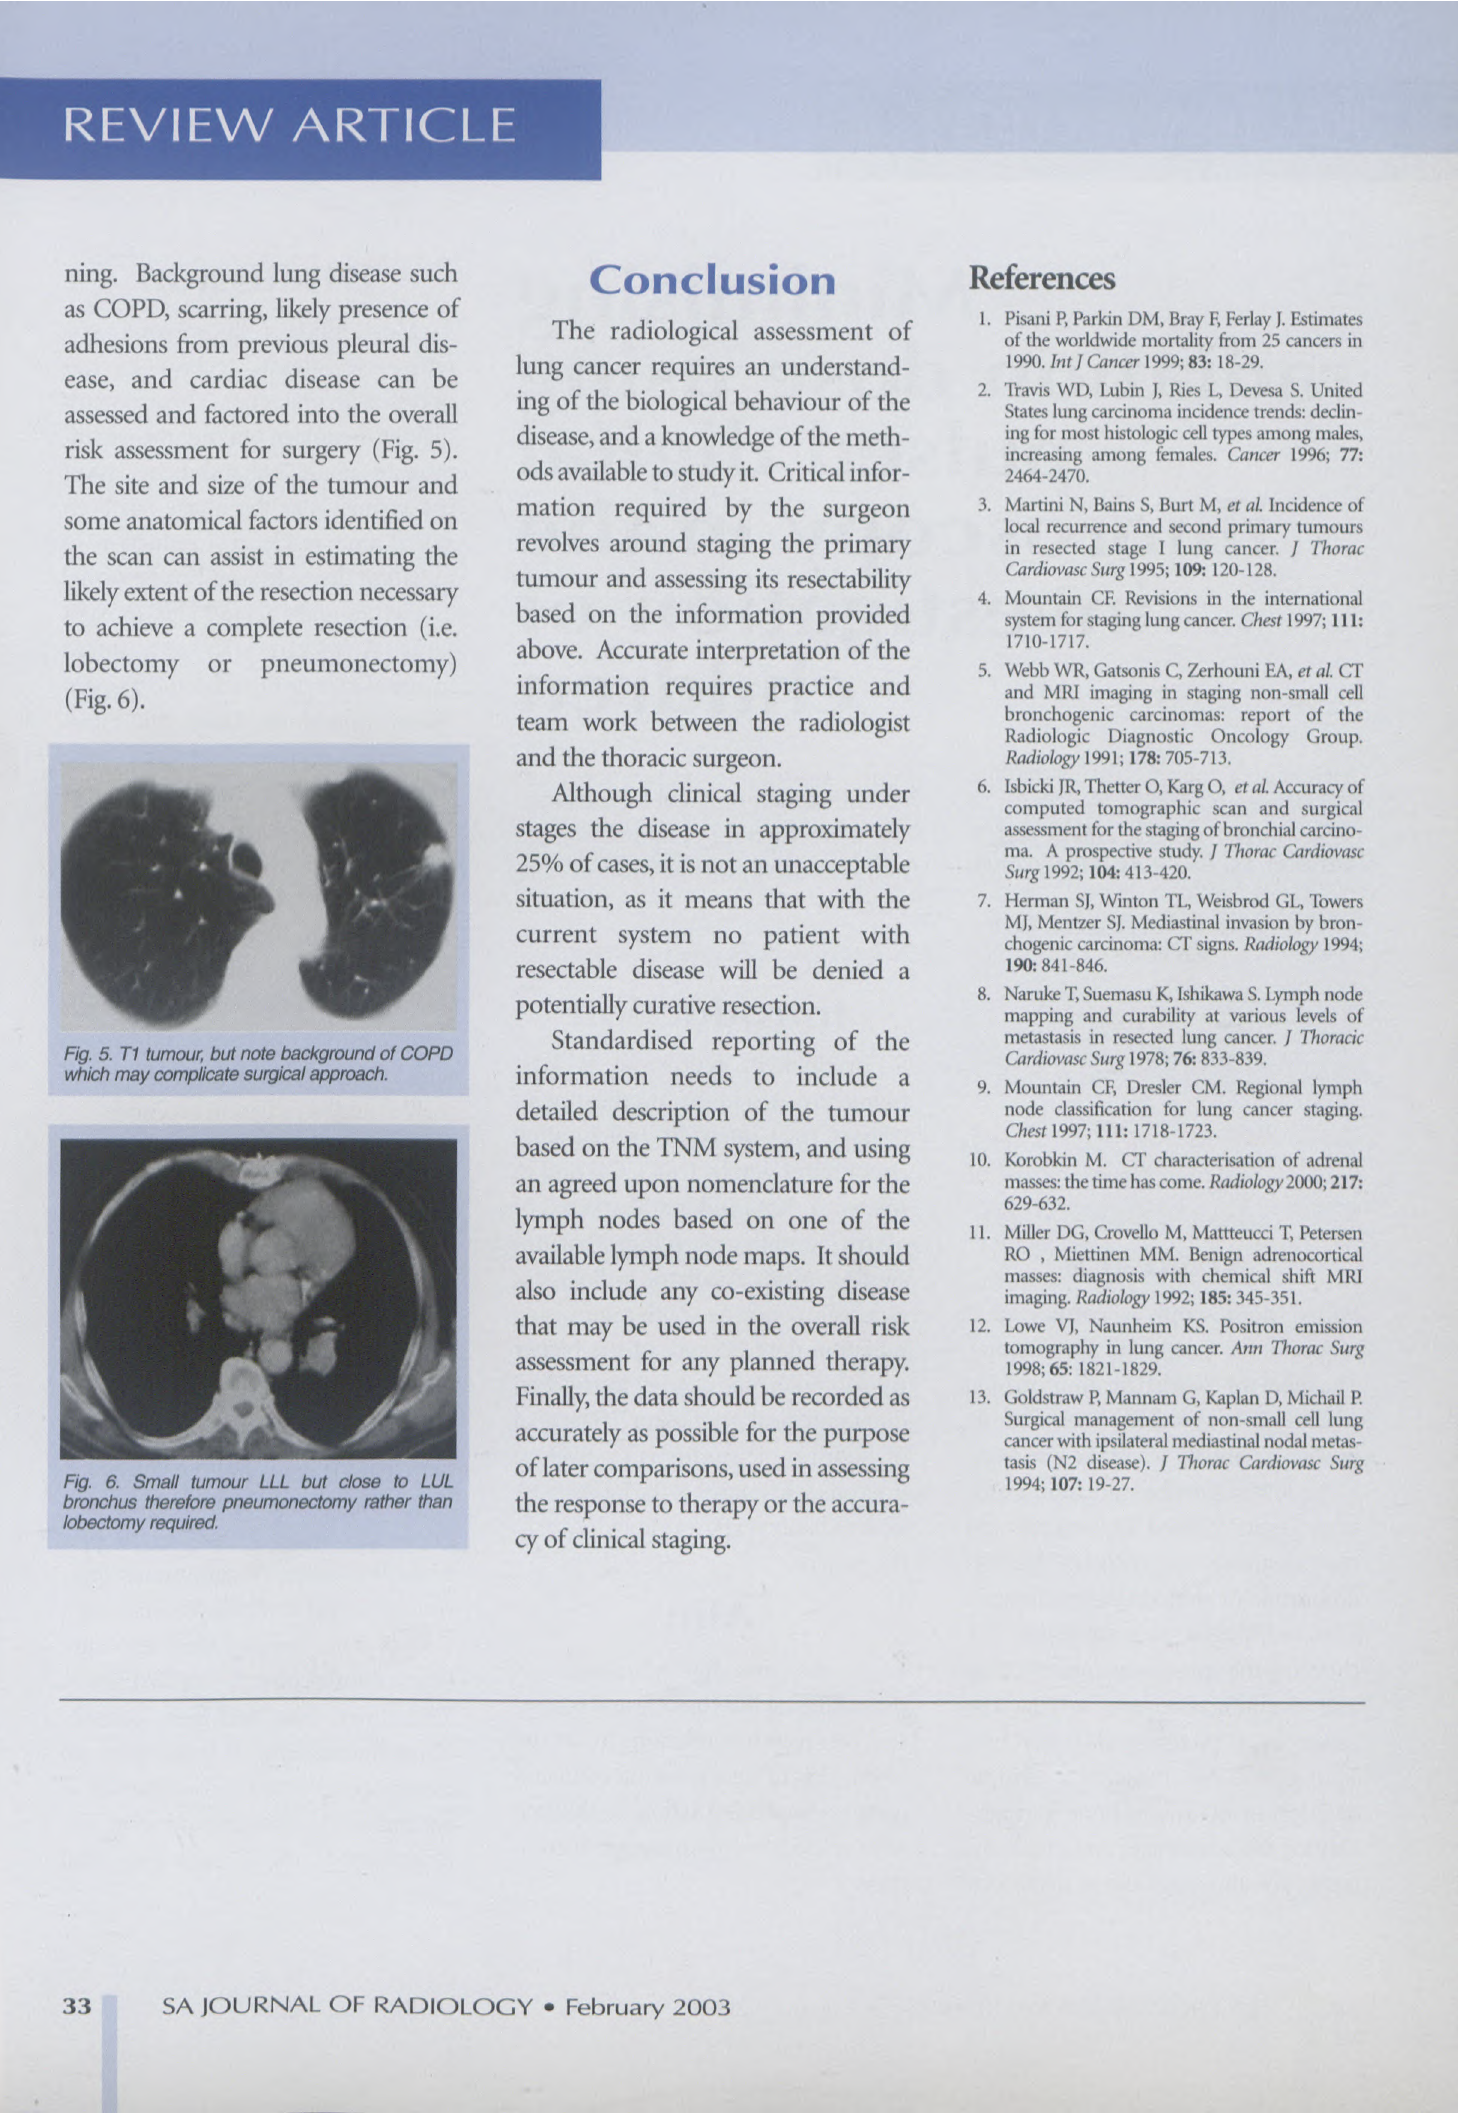
Fig. 6. Small tumour LLL but close to LUL bronchus therefore pneumonectomy rather than lobectomy